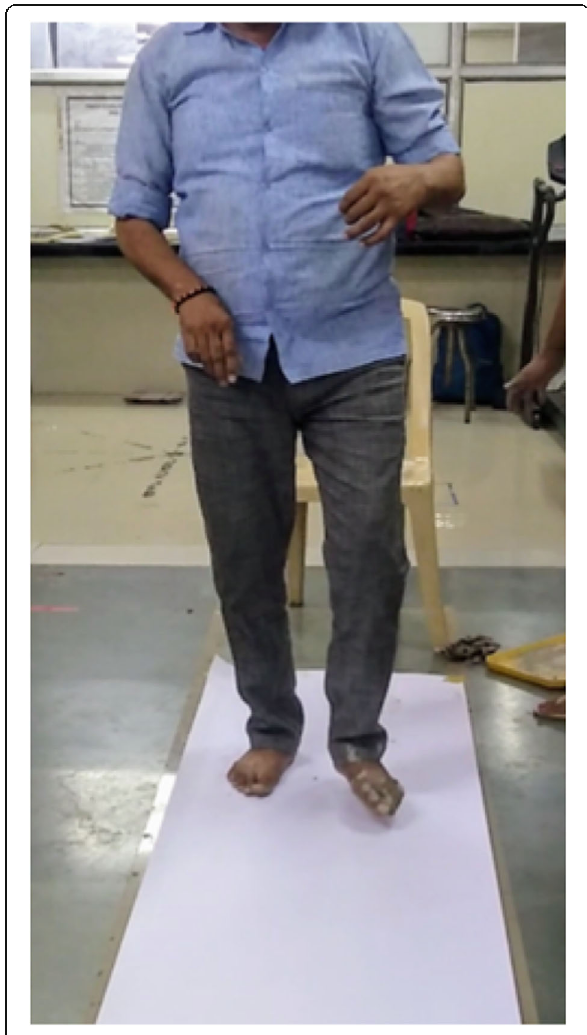
Fig. 4 Measuring step length using the foot print method